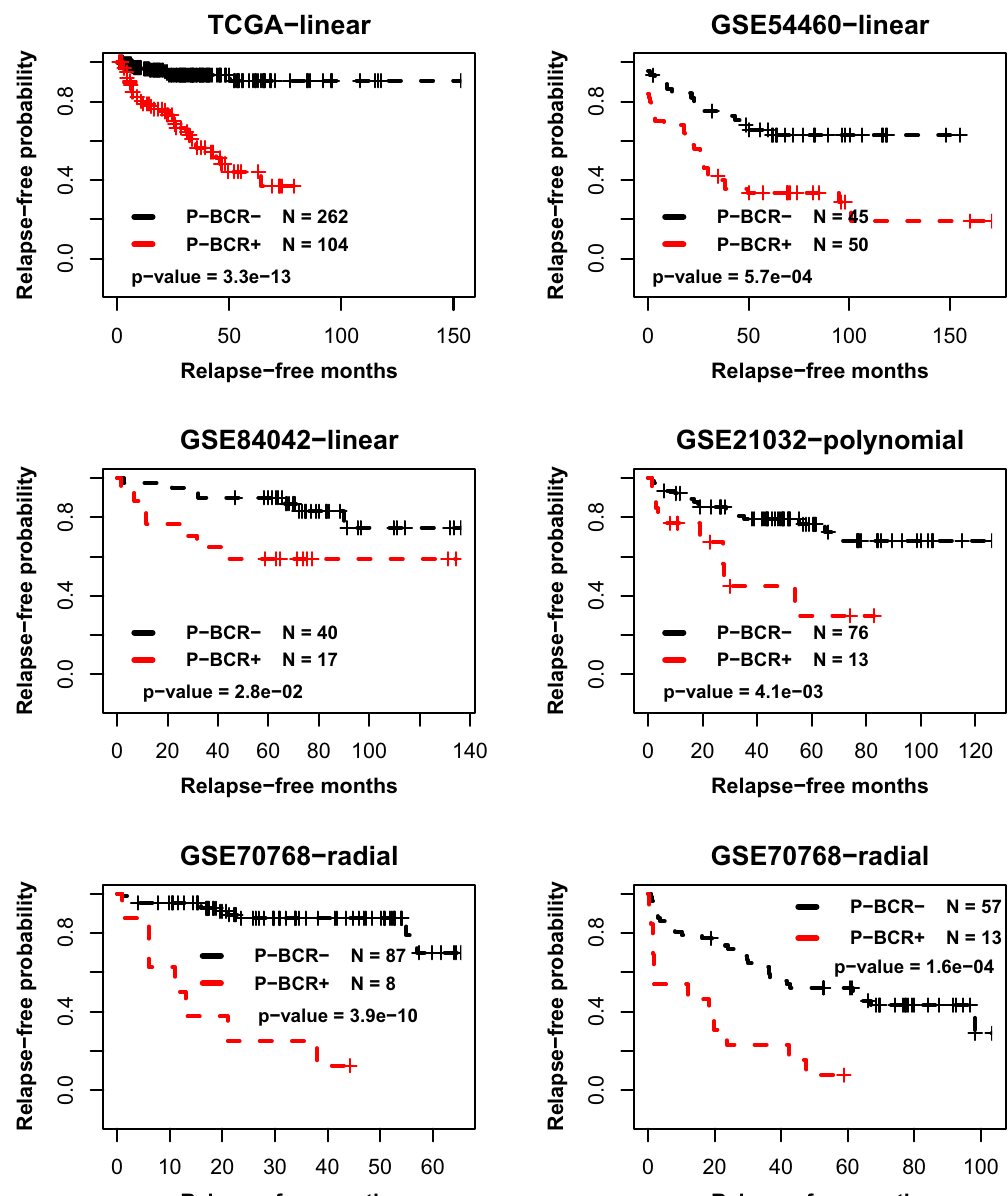
Figure 3. The association between RFS stratification and the BCR partition predicted using the TP53 mutation status-associated prognostic transcriptomic signature in the discovery dataset TCGA (-PRAD) and five external datasets, i.e., the GSE54460 and others. The “-linear”, “-polynomial” and “-radial” indicate the kernel functions in used the SVM models. The output BCR label (pre-BCR + and pre-BCR - ) of a patient in GSE70769 is predicted by the model trained using the GSE70768 dataset. For the patients in other cohorts, the labels are predicted via LOOCV. The survival profiles of pre-BCR + and pre-BCR - samples are depicted by red and black Kaplan–Meier curves,